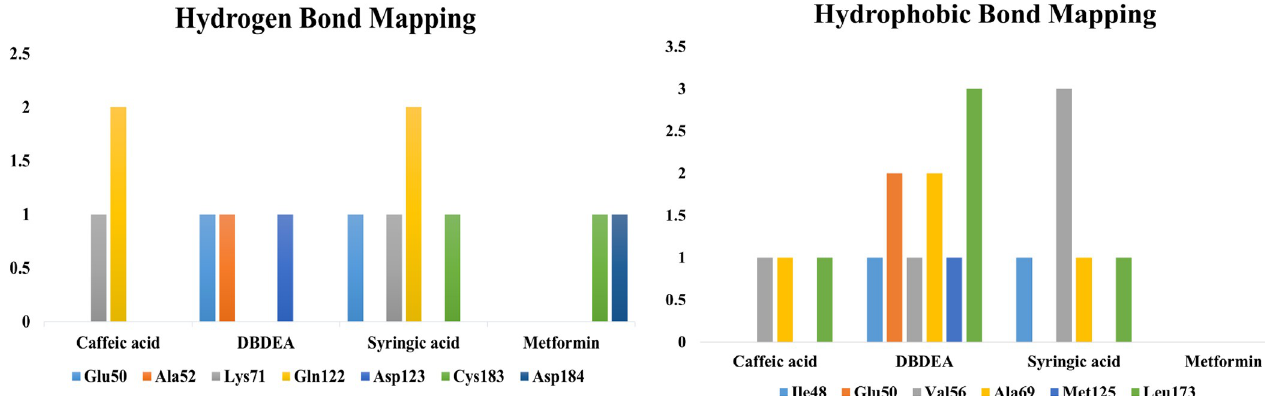
Fig 12. Hydrogen and hydrophobic bond mapping of the experimental compounds docked with human MAPK3 protein.